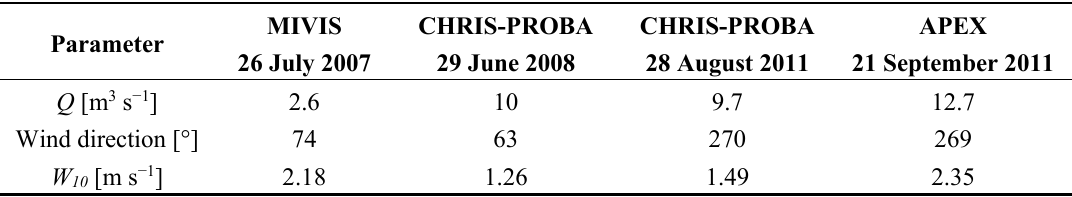
Table 2. Discharge and wind conditions for the simulated images